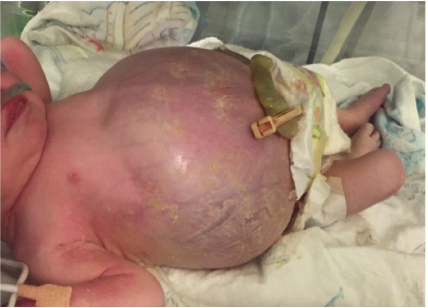
Figure 4: Surgical pathology: malignant neoplasm most consistent with malignant